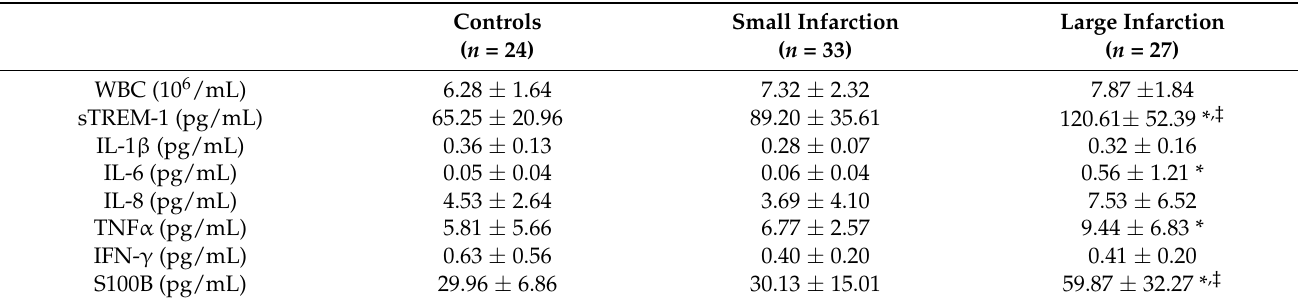
Table 2. Comparisons of WBC, sTREM-1, proinflammatory cytokines, and S100B in terms of the infarct size in acute ischemic